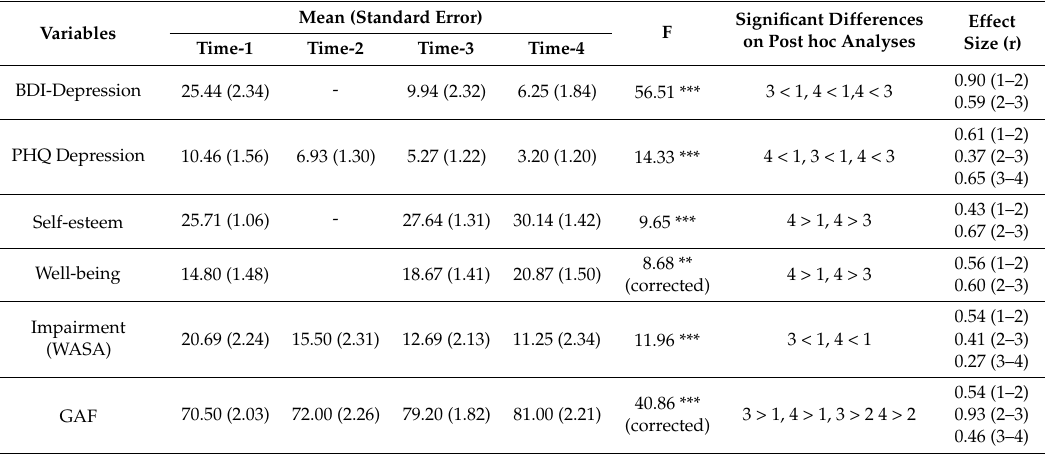
Table 6. Changes from baseline and stability of gains in follow-up sample ( n =